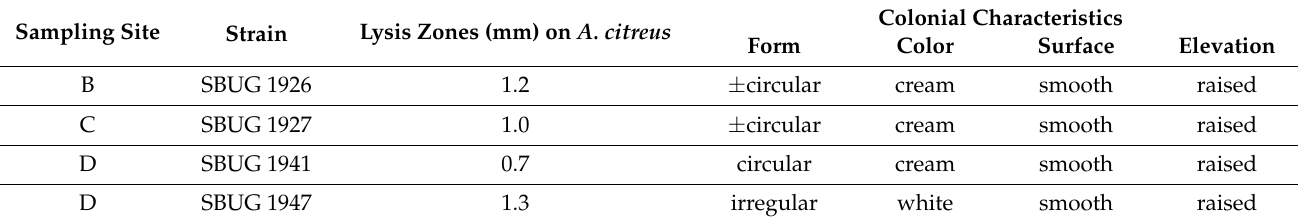
Table 2. Lysis activity on living cells of Arthrobacter citreus SBUG 321 on solid agar media. Colony morphology of the bacteriolytic isolates from different sampling sites of Lake Balkhash after 24 h of incubation; the strains were later identified as Paenibacillus apiarius (SBUG 1947) and Pseudomonas veronii (SBUG 1926, SBUG 1927 and SBUG